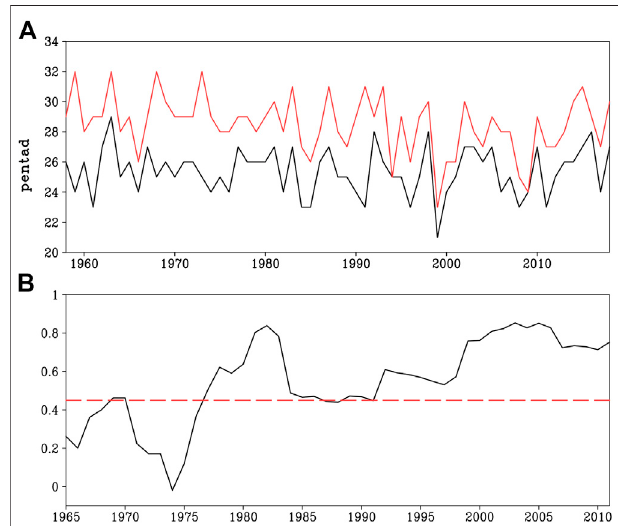
FIGURE2|(A) Time seriesofthemonsoon onsetpentad averagedover the selective BOBSM region (7.5 ° – 12.5 ° N, 85 ° – 95 ° E) and SCSSM region (5 ° – 15 ° N, 110 ° – 120 ° E). (B) A sliding correlation with a 15-years running window for thetimeseries of themonsoon onsetpentad ofBOBSM and SCSSM, and the red dashed line denotes values reaching the 90% con fi dence level.